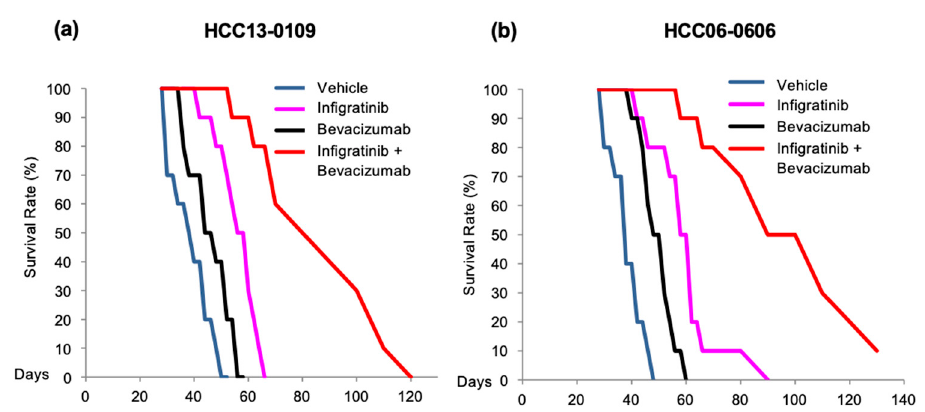
Figure 5. Effects of Infigratinib/Bevacizumab on the survival of mice bearing HCC13-0109 and HCC06-0606 tumors. HCC13-0109 and HCC06-0606 orthotopic models were established as previously described [39]. Mice bearing tumors were treated for 28 days, as described in the Materials and Methods. Each treatment group consisted of 10 mice. Treatments were initiated when the tumors reached sizes of approximately 100–150 mm 3 . Kaplan–Meier survival analysis for HCC13-0109 ( a ) and HCC06-0606 ( b ) models are shown. Infigratinib/Bevacizumab significantly improved the OS of mice bearing HCC13-0109 (Log-rank test, p = 0.0004124) or HCC06-0606 (Log-rank test, p = 0.0009231) compared to Infigratinib treatment alone.